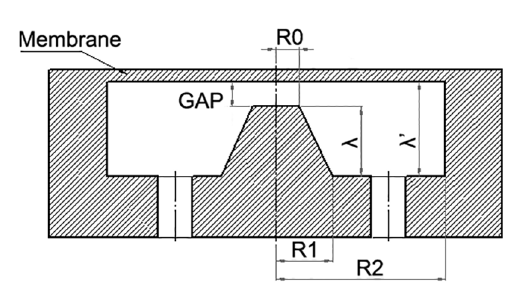
Figure 1. Schematic drawing of the niobium reentrant